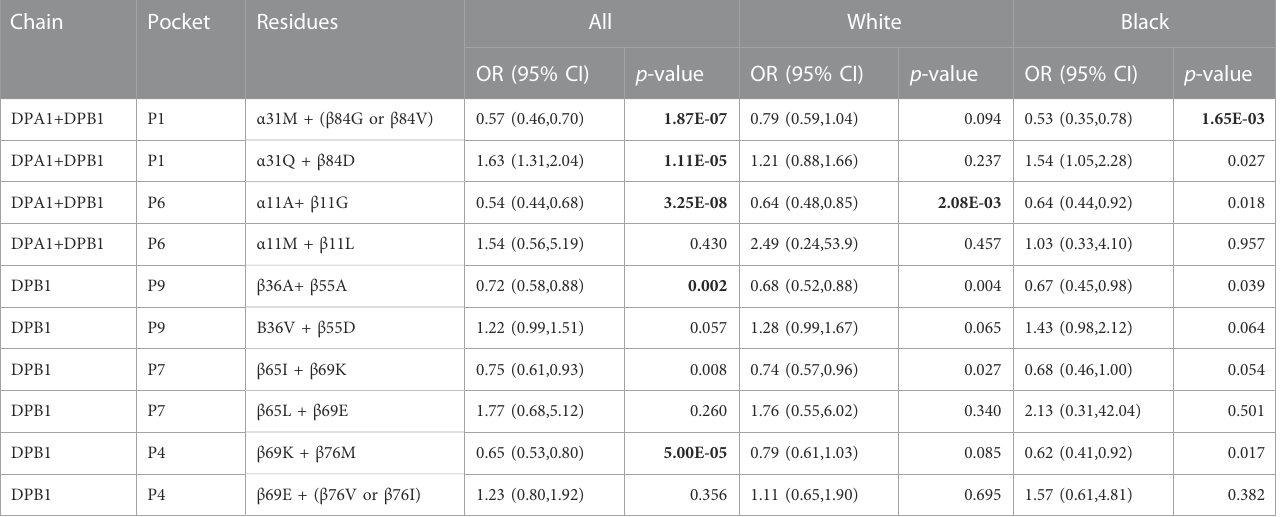
TABLE 5 HLA-DP Pocket Residue Analysis. Correction factor of 10 ( p < 0.005; bold text). Chain